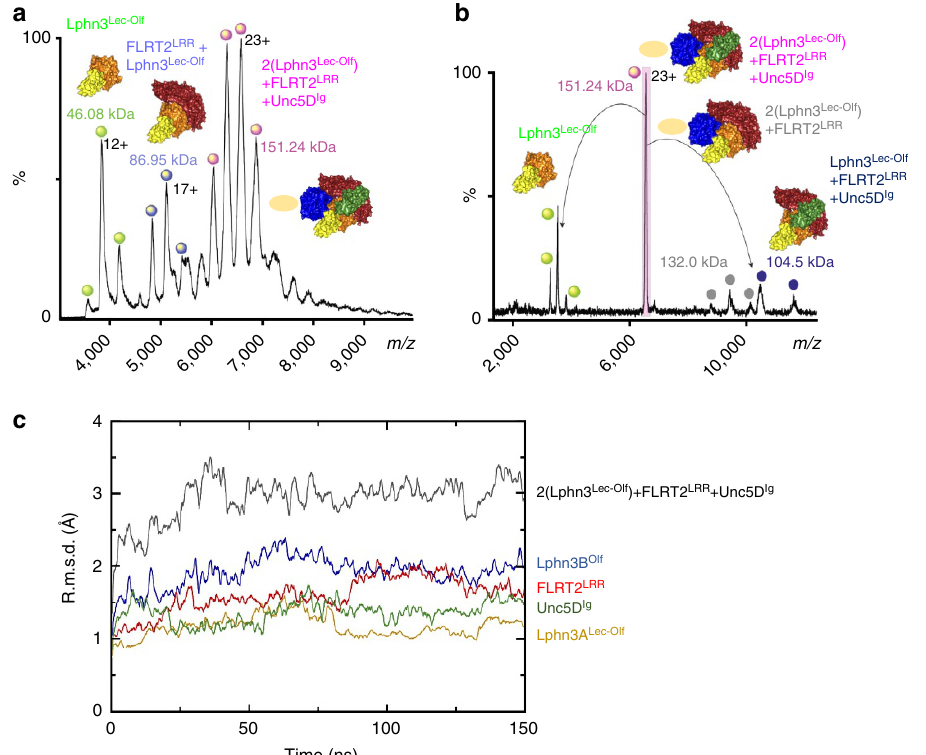
Figure 4 | Mass spectrometry and molecular dynamics simulations demonstrate the 1:1:2 complex forms in solution. ( a ) We mixed purified FLRT2 LRR , Unc5D Ig and Lphn3 Lec–Olf in a 1:1:2 ratio and acquired MS data. The profile reveals masses corresponding to a 1:1:2 tetramer, as well as smaller subcomplexes and Lphn3 Lec–Olf on its own. The assigned species are depicted as surface models above the corresponding peaks. Colours of the models are as in Fig. 3. The Lphn3B Lec domain, which is not resolved in the crystal structure, is shown as a pale yellow oval. ( b ) We isolated the tetramer peak shown in a and performed MS/MS to reveal subcomplexes present in the original peak species. ( c ) The 1:1:2 tetramer model remained stable over 150ns of molecular dynamics simulation. C a root mean squared deviations (r.m.s.d.s) across the trajectories are plotted for the total complex (black) and for the individual subcomponents (colours as